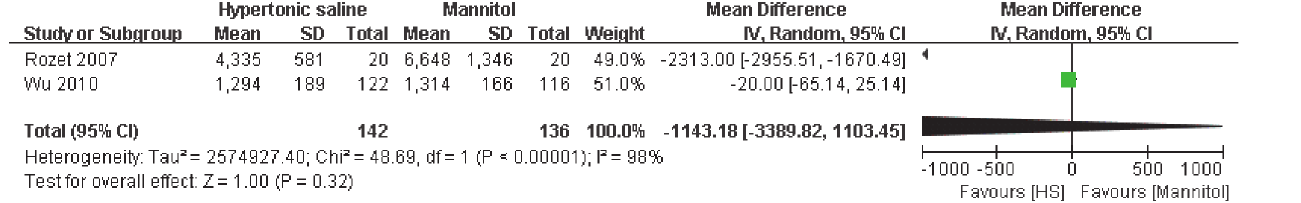
PLOS ONE | DOI:10.1371/journal.pone.0117314 January 30,